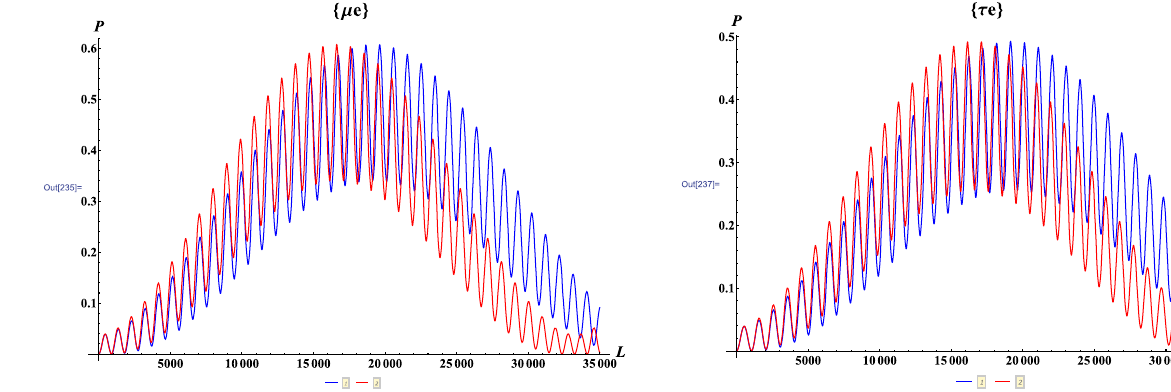
Fig. 3 Same analysis of Fig. 1, but for the oscillation probability from ν ν e to